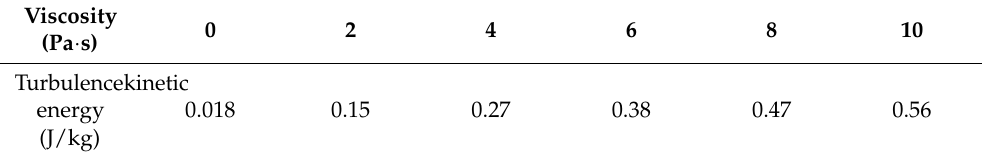
Figure 9. Convergence test.